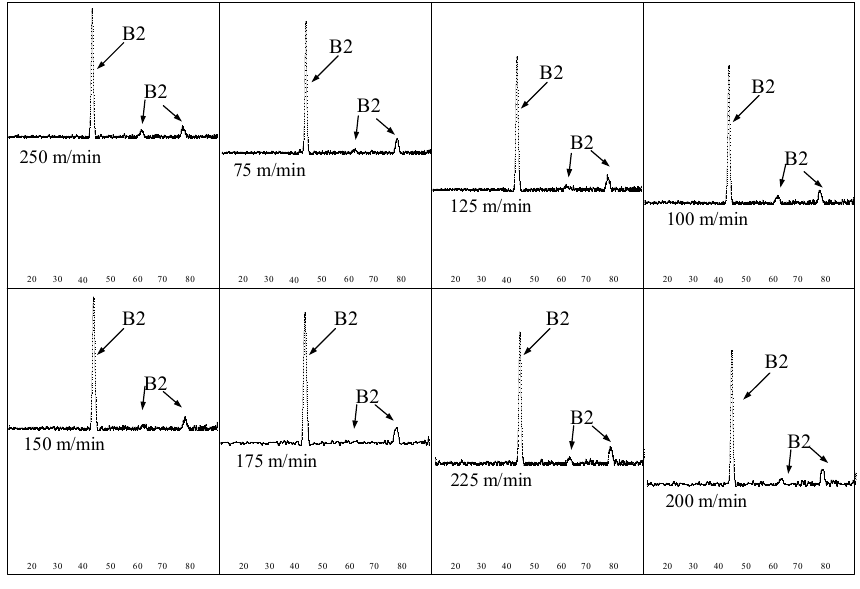
Figure 3. XRD pattern of the milling surface (B2: austenite).